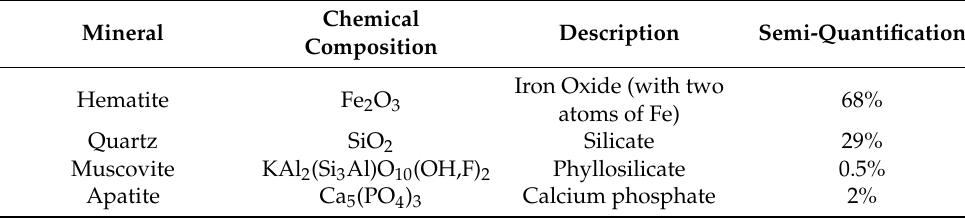
Table 1. Minerals constituting the samples with their chemical composition and